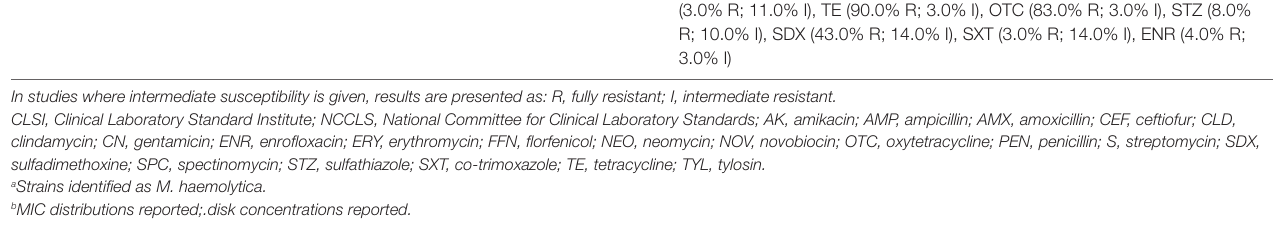
TABLe 6 | Summary of results of 7 phenotypic studies on antimicrobial resistance of S . Ornitobacterium rhinotracheale (ORT) and B. avium from poultry. Study Reference (country)